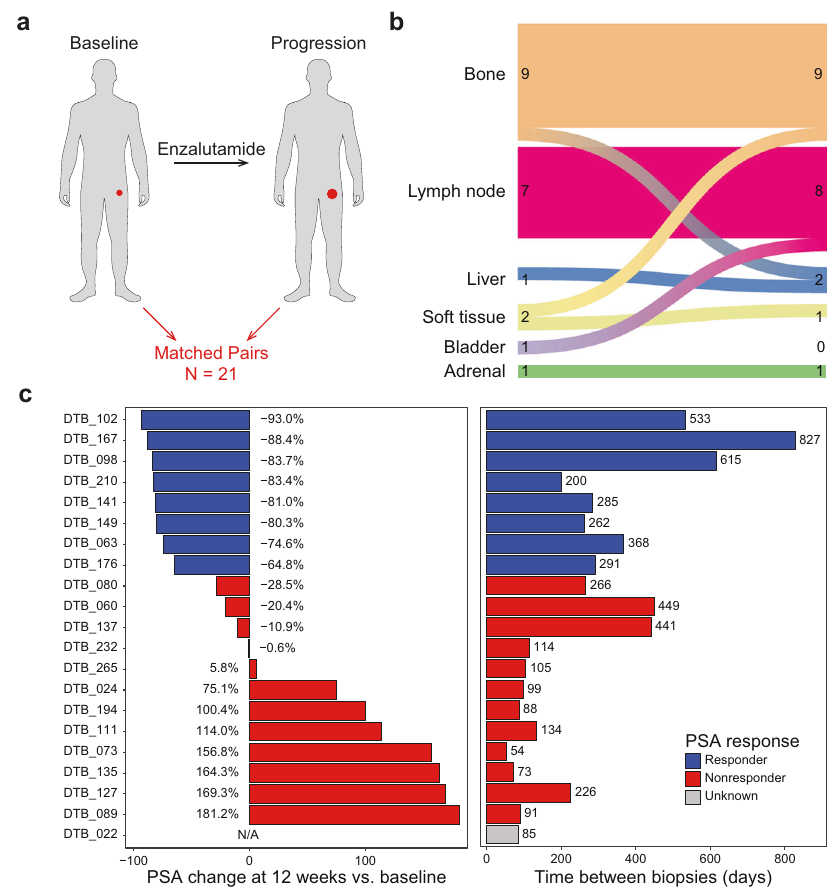
Fig. 1 | Study biopsy and clinical information. a Study schematic. b Sankey diagramshowingsiteofbiopsyatbaseline(left)andatprogression(right).Values indicatenumberofbiopsiesperformedon eachtypeoftissueatbaseline(left)or progression (right). c Left panel shows PSA change at 12 weeks for each patient.